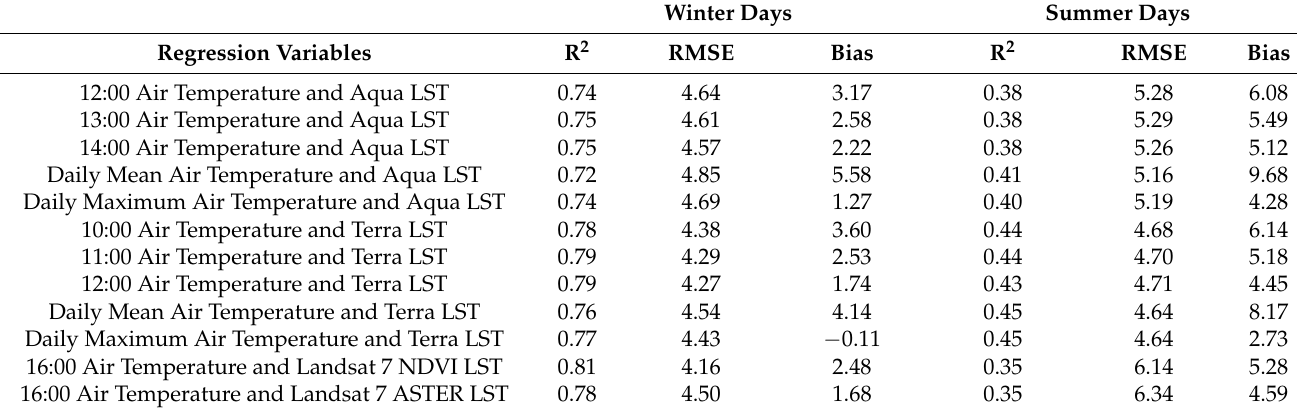
Table 2. The results from regression analyses for both MODIS Aqua and Terra and Landsat 7 for winter days (Days 1–99 and 291–366) and summer days (Days 100–290) of every year between 2000 and 2019. The T air relationships with the best R 2 results are included. All p -values are